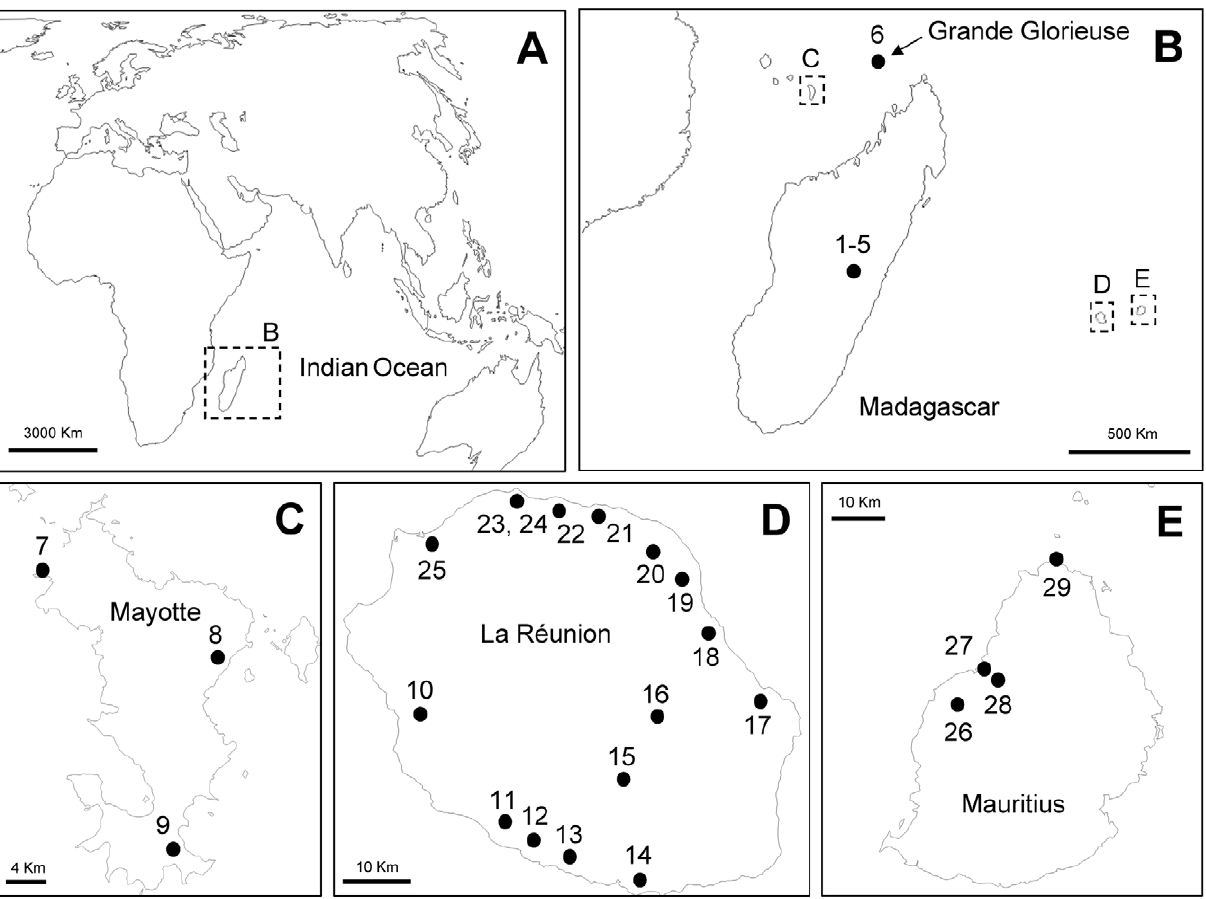
Figure 1. Sample site locations. A: location of the study area; B, Madagascar and surrounding islands, including Grande Glorieuse; C, Mayotte; D, La Re´union; E, Mauritius. Populations are numbered from 1 to 29. Numbers correspond to those in Table 1.